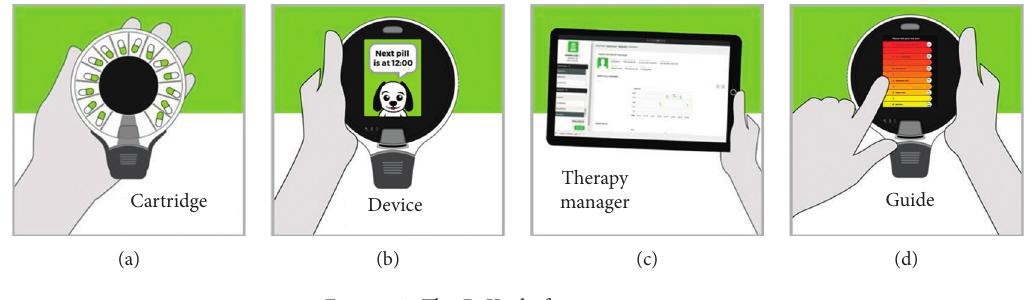
Figure 4: The ReX platform